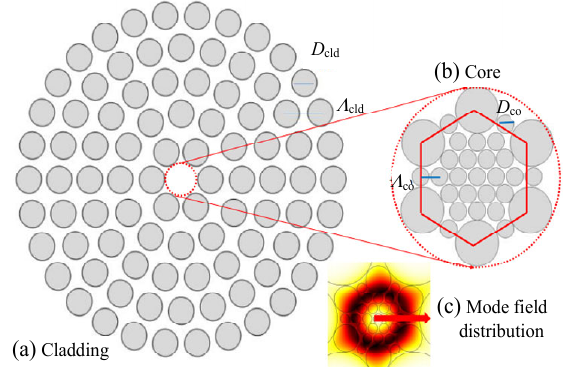
Fig. 1 Schematic of end-faced view of proposed BC-PCF: (a) cladding region, (b) core, and (c) modal